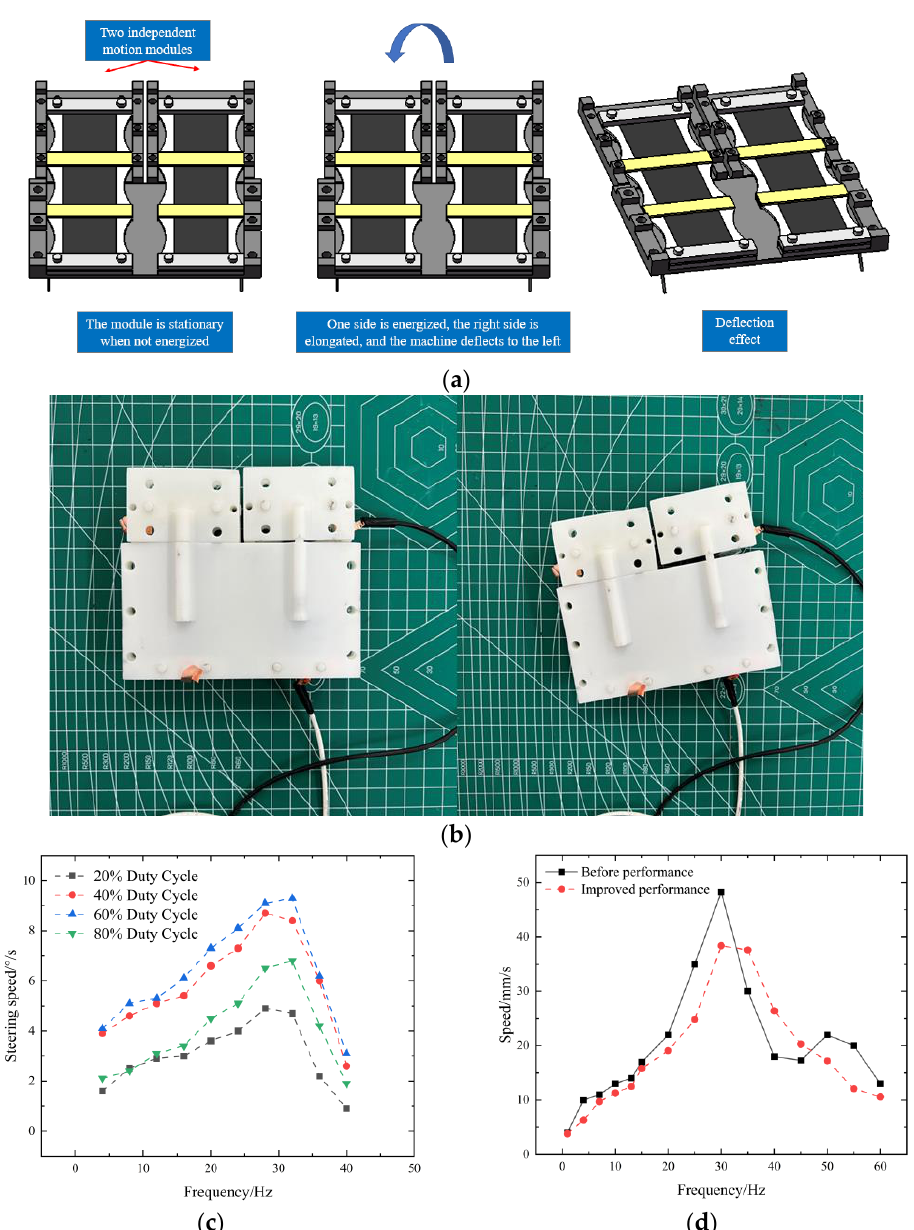
Figure 6. ( a ) The diagram shows how the robot was improved to give it the ability to steer using two mutually independent actuators. ( b , c ) Turning ability under different duty cycles. The best turning was achieved at a duty cycle of 60%. ( d ) The figure shows the comparison of crawling performance after the modification. The figure shows that the straight-line capability after the improvement was about 80% of that before the